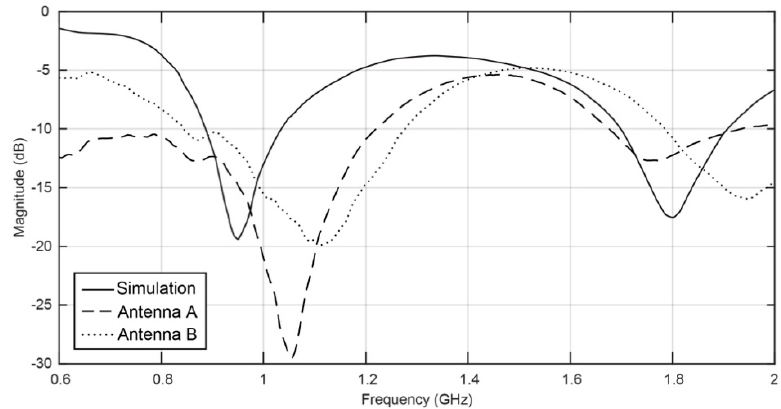
Figure 4. Simulated and measured return loss of laminated antennas.